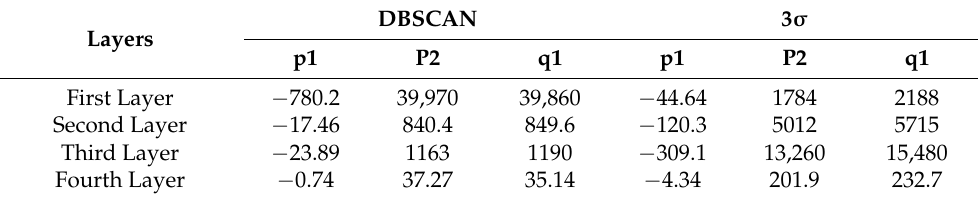
Table 2. Model parameters of grain temperature correlation coefficient threshold on the XOY